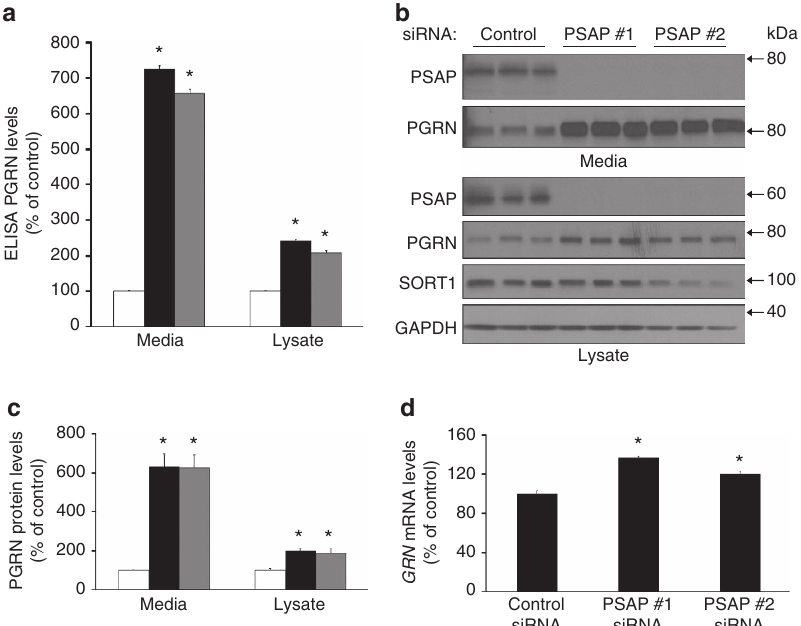
Figure 3 | Reducing PSAP levels increases PGRN levels. ( a ) PGRN levels in the media and cell lysates of HeLa cells were measured by the R&D ELISA post siRNA transfection with either a control siRNA (white bars) or PSAP-targeted siRNAs #1 and #2 (black and grey bars, respectively ( n Z 12 per group). ( b ) Immunoblot of media and lysates from HeLa cells transfected with control or PSAP siRNAs. ( c ) Quantification of PGRN immunoreactivity from immunoblots of HeLa cell media and lysates post PSAP knockdown with PSAP siRNA #1 (black bars), #2 (grey bars) or a control siRNA (white bars; n ¼ 12 per group). ( d ) GRN mRNA levels were quantified in HeLa cells post PSAP knockdown ( n ¼ 5 per group). In all graphs, the values represent the mean ± s.e.m. *Differs from controls, P o 0.001 by one-way